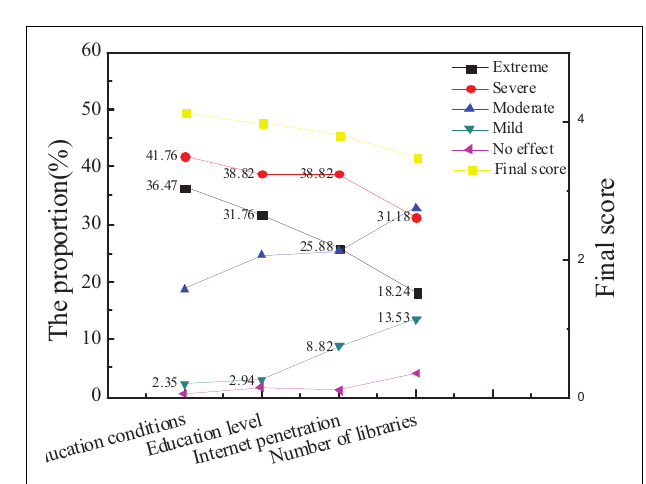
FIGURE 8 | Attention and scores of the audiences on influencing factors of city environmental